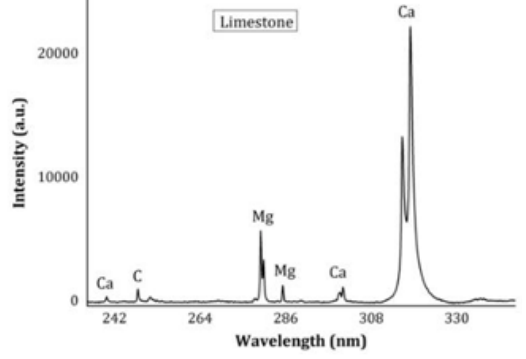
Figure 7. LIBS spectrum acquired in the range 240–335 nm showing the C line at 247.85 nm, Ca lines at 239.86, 300.68, 300.94, 315.88, 317.93 nm and Mg lines at 285.21, 279.55, 280.27 nm in the unaltered limestone